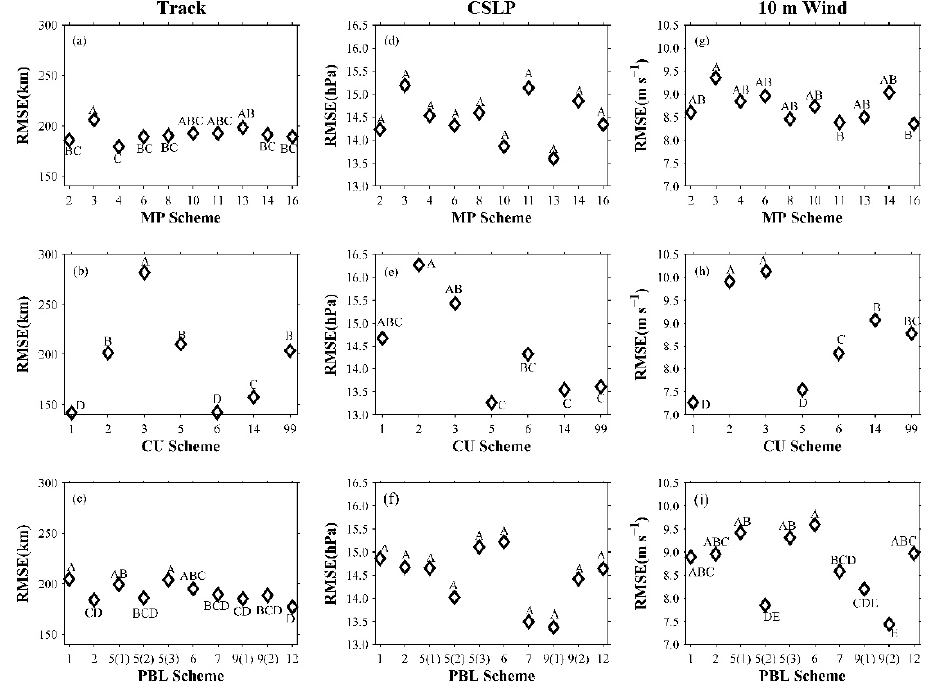
Figure 2. The first round of scheme evaluation results for the ( a – c ) track, ( d – f ) central sea level pressure (CSLP), and ( g – i ) 10 m maximum wind speed (10 m wind) of 15 typhoons using the Tukey’s test